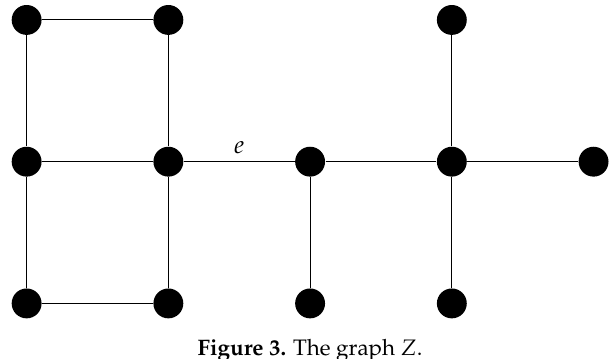
Figure 3. The graph Z